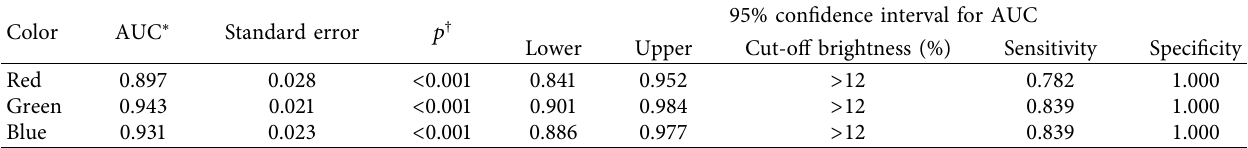
Table 3: Sensitivity and specificity of the K -color test.